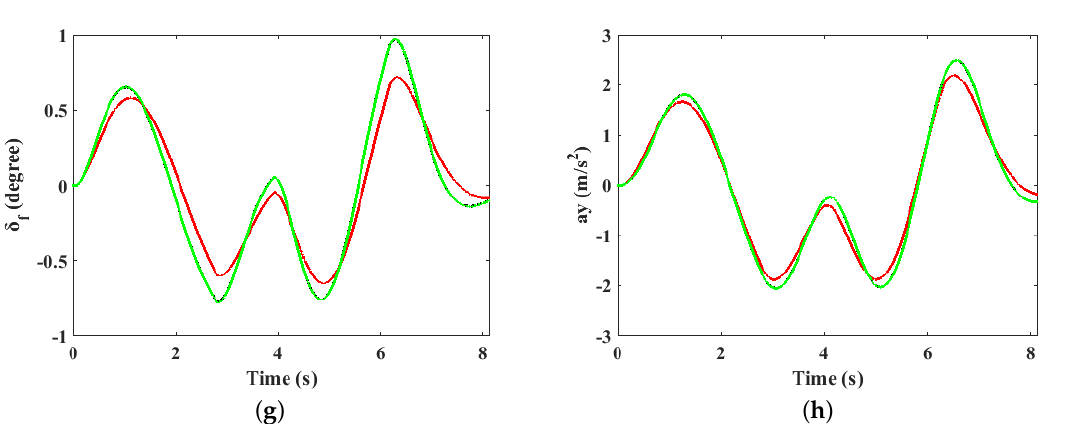
Figure 15. Extended double lane change with Motor I and v x = 80km/h: ( a ) Path; ( b ) Longitudinal velocity; ( c ) Working area; ( d ) Wheel torques; ( e ) Yaw moment; ( f ) Power; ( g ) Front steering angle; ( h ) Lateral acceleration.